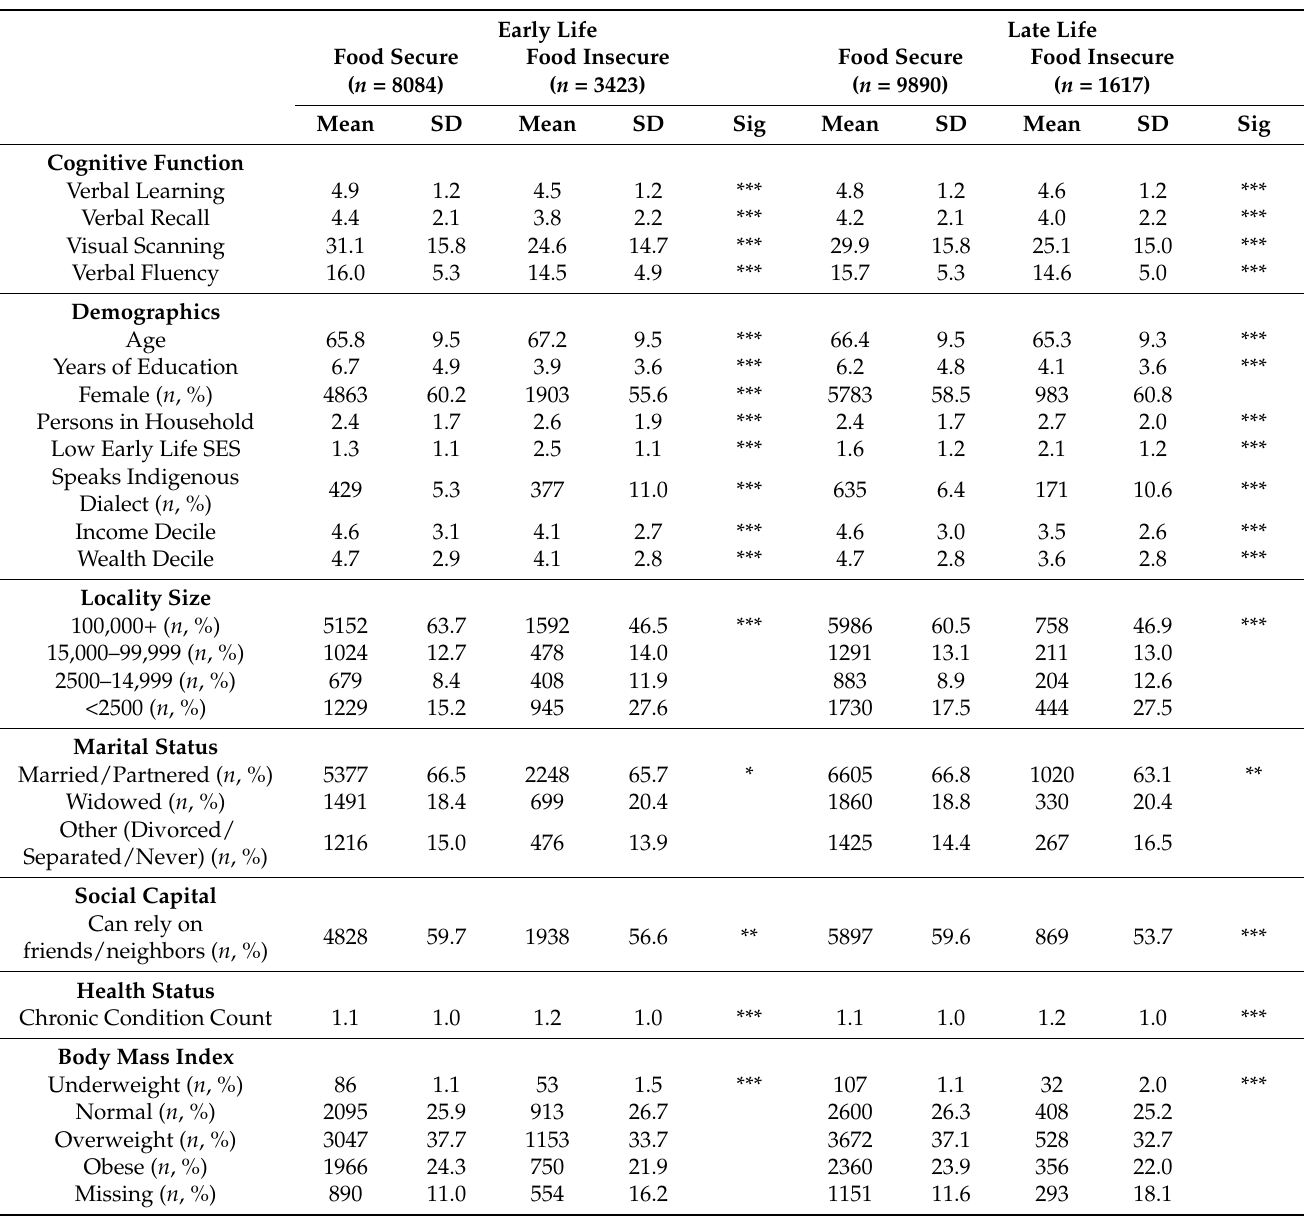
Table 1. Sociodemographic, cognitive, and health characteristics of Mexican adults (age 50+) by food insecurity. Early Life Late Life Food Secure Food ( n = 8084)